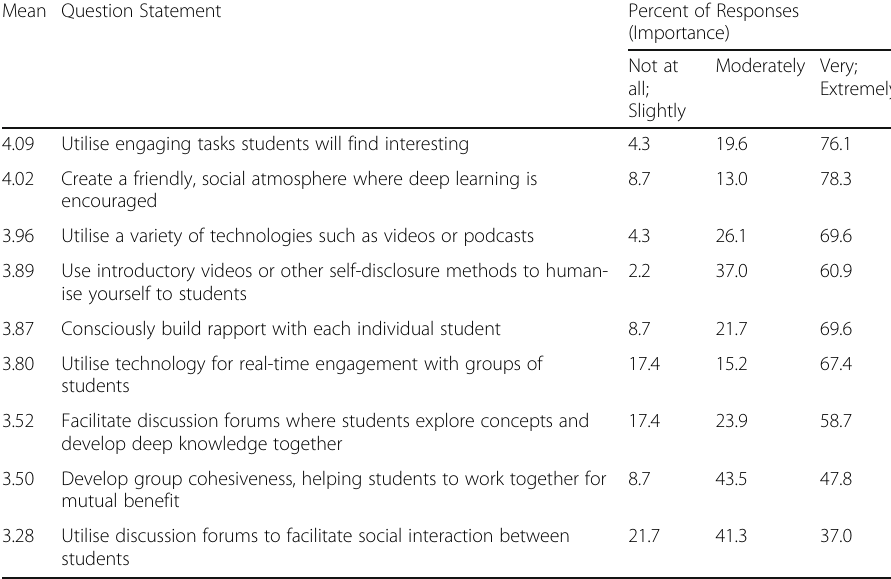
Table 6 Conception of teaching